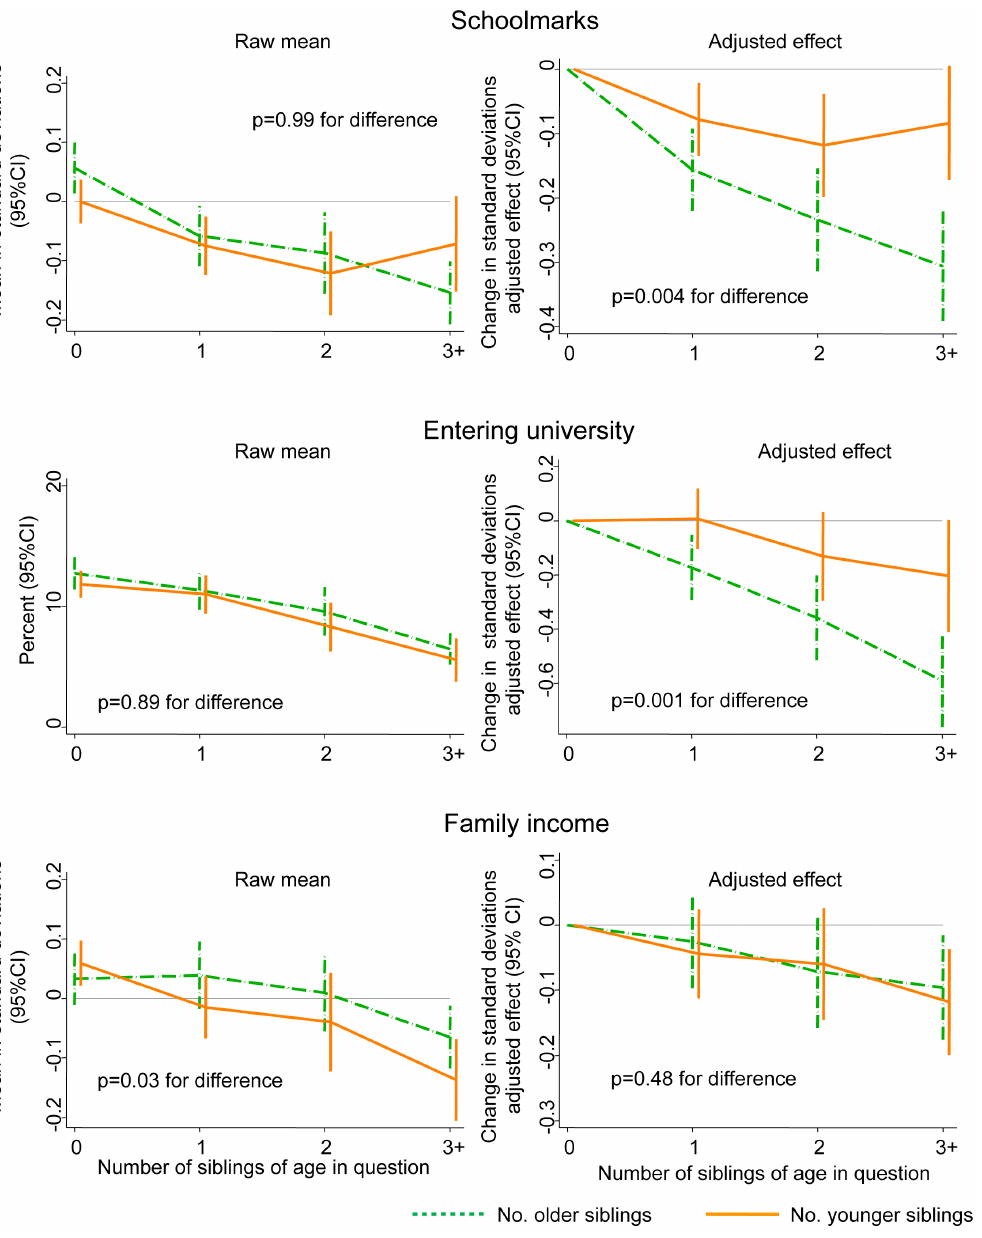
Figure 3. Association of the cohort members’ number of older versus younger siblings with the cohort members’ schoolmarks, educational attainment and adult income. p-values presented are for the difference in the effect of number of older versus younger siblings. In the left-hand column these p-values come from models only adjusting for these two sibling variables. In the right-hand column the p-values come from multivariable models additionally adjusting for the early-life characteristics shown in Table